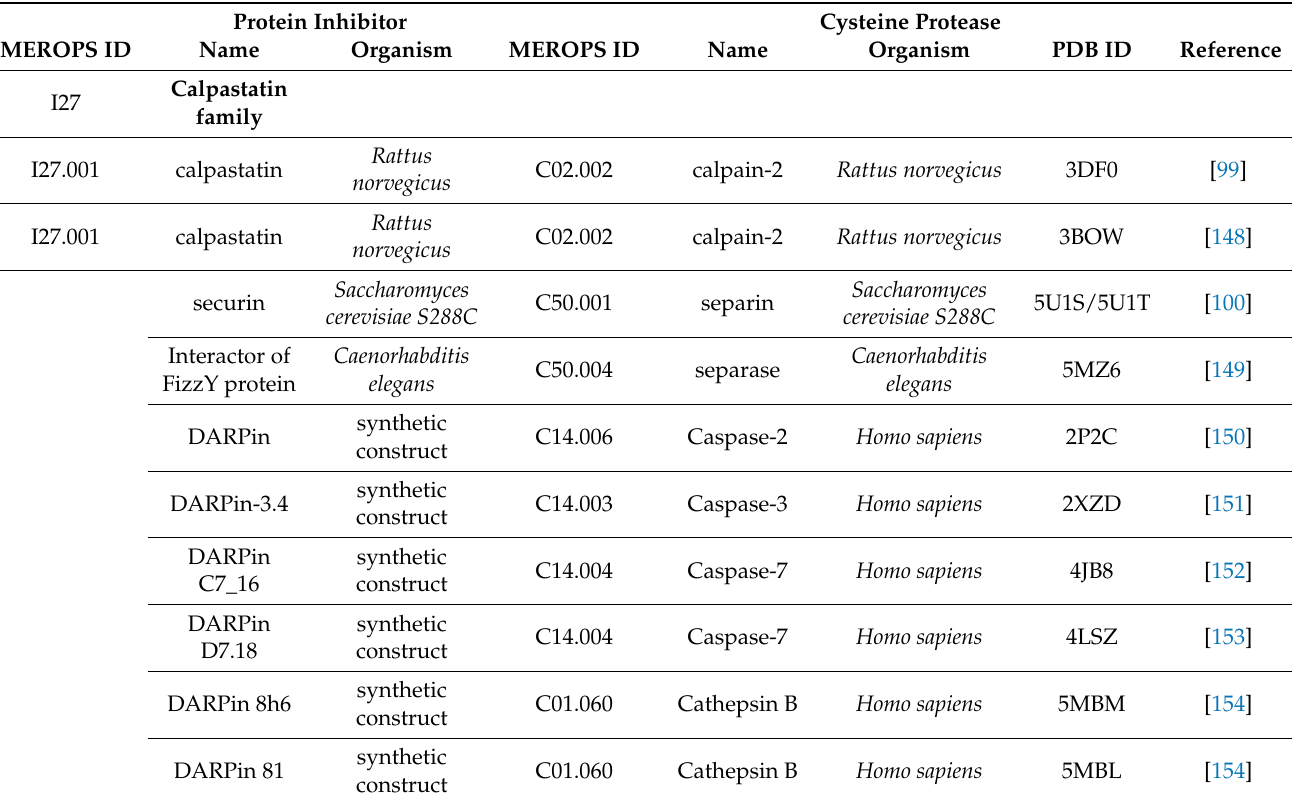
Table 5. List of the available structures of the complexes between protein inhibitors and cysteine proteases: calpastatins, securing, and designed ankyrin repeat proteins